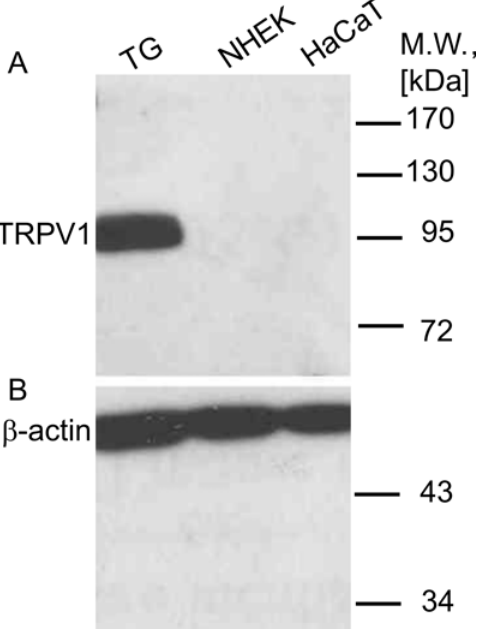
Figure 4. The TRPV1 protein level in the keratinocytes was under detection limit in Western blotting assay. Proteins were extracted from human trigeminal ganglion (TG), primary human keratinocytes (NEHK) and the HaCaT cell lines. With a commercially available polyclonal antibody only the TG expressed 94 kDa TRPV1 can be detected (A). The equal loading of protein extracts was validated by b -actin ( , 50 kDa), a common, ubiquitously expressed cytoskeletal protein (B).